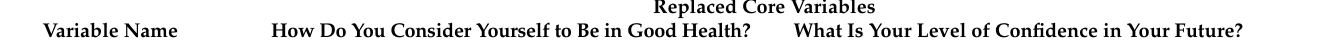
Table 11. Sample robustness test